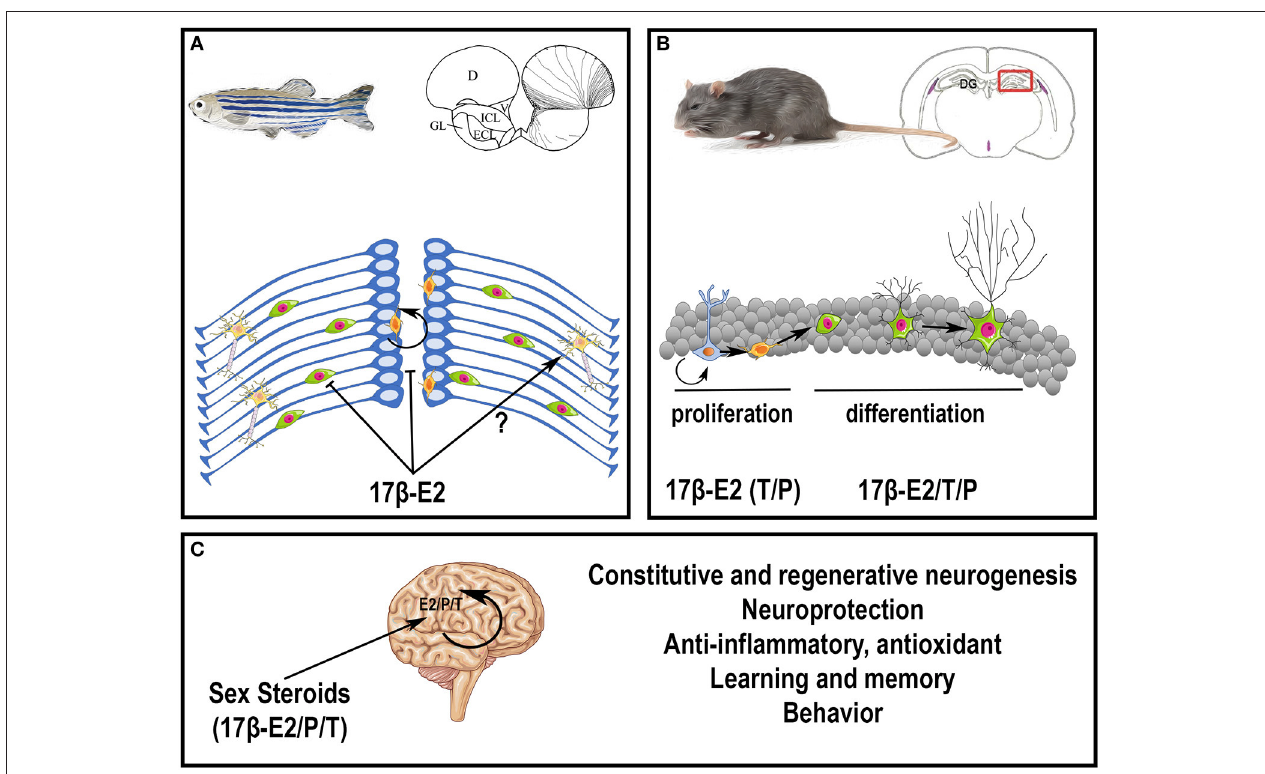
FIGURE 3 | Potential roles of steroids in the brain. (A) Effects of 17 β -estradiol on neurogenesis in adult zebrafish. At the top, the scheme represents a zebrafish and a transversal brain section through the olfactory bulbs, taken from Menuet et al. (2005). The lines on the right hemisphere correspond to radial glial cells, that behave as neural stem cells. At the bottom, the scheme illustrates neurogenesis events occurring on the zebrafish brain. Radial glial cells (blue) give rise to new neurons (green) that migrate and differentiate into mature and functional neurons (yellow). The orange cells close to the ventricle vicinity are further committed progenitors. It was shown that 17 β -estradiol impairs neural progenitor proliferation and new born cell migration; the data obtained for neural differentiation and survival are not clear ( Diotel et al., 2013; Pellegrini et al., 2015). (B) Effects of sex steroids on neurogenesis in adult rodents. At the top, the scheme represents a rodent and a transversal brain section through the dentate gyrus (DG) of the hippocampus (framed box), where neurogenesis is maintained during adulthood. At the bottom, the scheme illustrates neurogenesis events occurring in the granular cell layer of the dentate gyrus. Radial glial cells (blue light) give rise to neural progenitors (orange) that give birth to new neurons (green with a small neuritic arborescence) that migrate and differentiate into mature and functional neurons (green with a huge neuritic arborescence). In general, 17 β -estradiol (17 β -E2) favors neural stem cell/progenitor proliferation; to a lesser extent, testosterone (T) and progesterone (P) also exert positive role on proliferation; 17 β -estradiol, testosterone and progesterone also promote neuronal migration and differentiation ( Heberden, 2017). In addition, these three sex steroids promote new born cell survival in constitutive and regenerative neurogenesis. Note, that the effects of sex steroids on neurogenesis could be dependent of the timing, the concentration, the rhythm of exposure and the regions targeted. For instance, estradiol treatment has been shown to decrease neurogenesis in the SVZ (Brock et al., 2010 ). (C) Peripheral steroids and neurosteroids impact brain functions and homeostasis, by modulating neurogenesis under homeostatic and regenerative conditions, by promoting neuroprotection, learning, and memory, and by exerting anti-inflammatory and antioxidant properties. They also modulate sexual